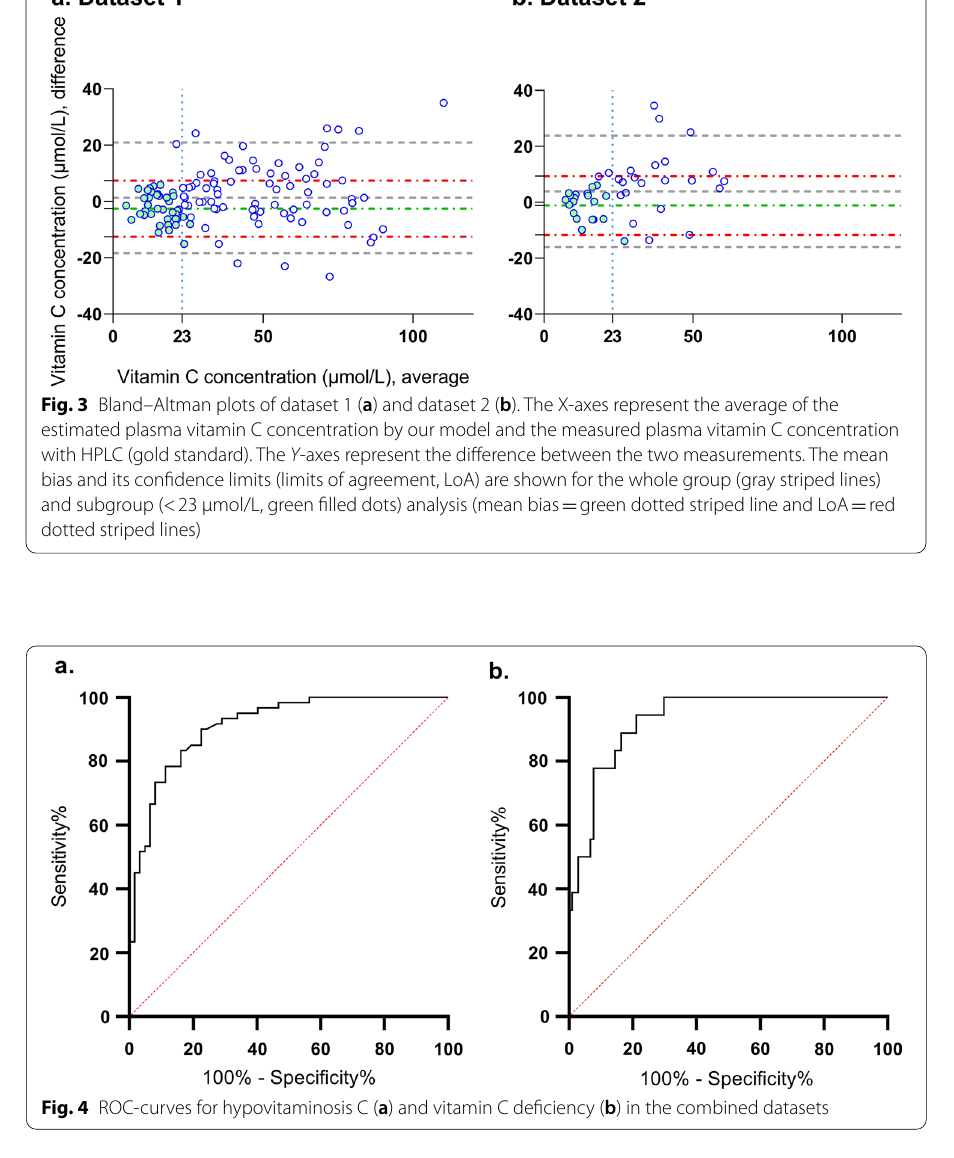
Fig. 4 ROC‑curves for hypovitaminosis C ( a ) and vitamin C deficiency ( b ) in the combined